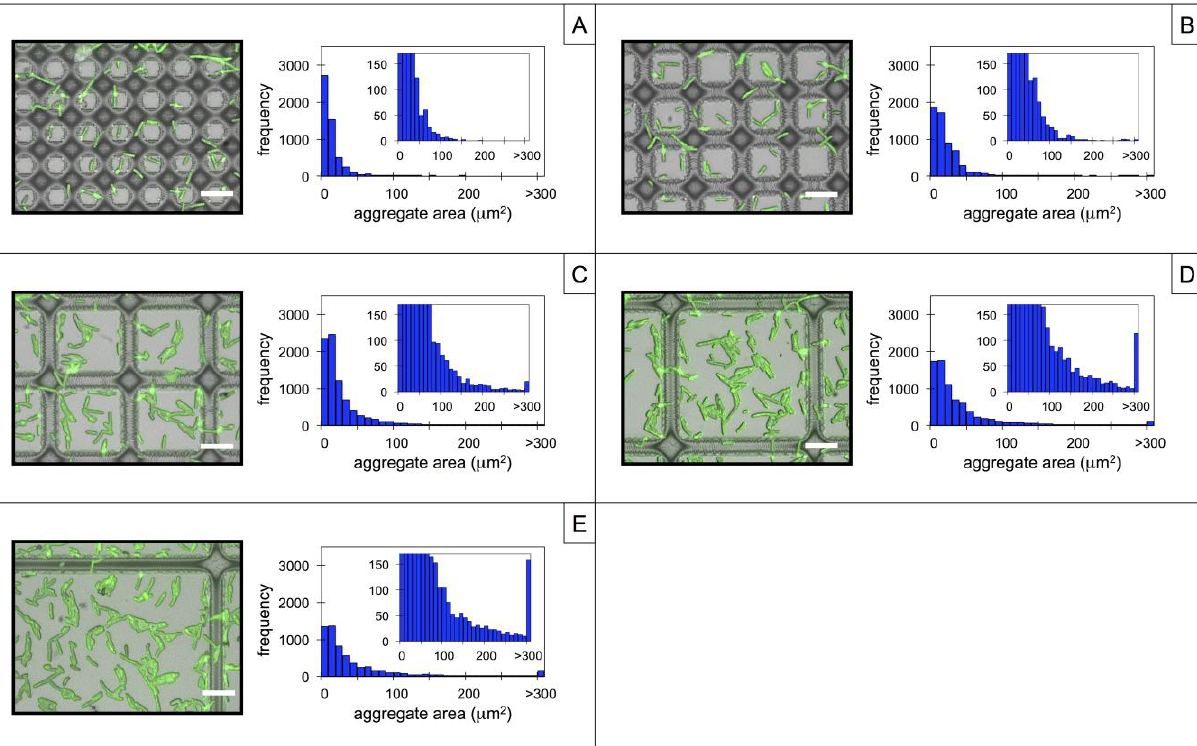
Figure 3. Composite brightfield-fluorescence images (100×) and corresponding histogram plots of surfaces containing PGMA- b -PVDMA films patterned as square grids with a pitch of ( A ) 10 µm, ( B ) 15 µm, ( C ) 25 µm, ( D ) 45 µm, and ( E ) 85 µm after wheat germ agglutinin (WGA)-functionalization and microbe incubation. Aggregate sizes were measured over a 2.0 mm 2 area for each grid. Histogram insets are zoomed-in plots showing the frequencies of larger aggregates. Scale bar =10 µm in all images.